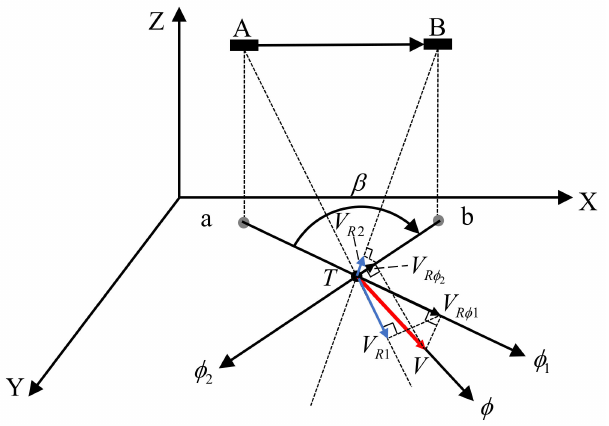
Figure 4. Schematic diagram for vector current velocity